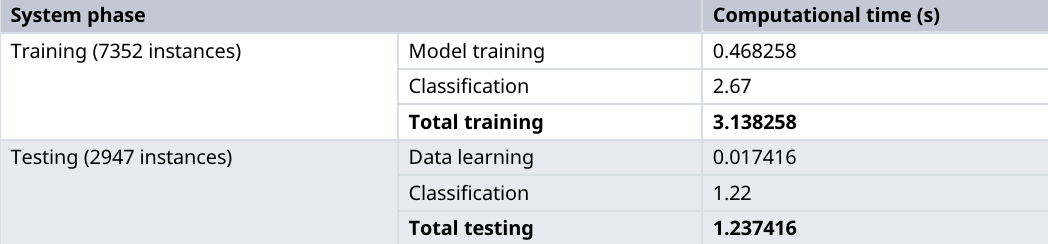
Table 4. Computational time of Stacked Discriminant Feature Learning (SDFL). Classifier = Nearest Neighbour (NN) classifier.